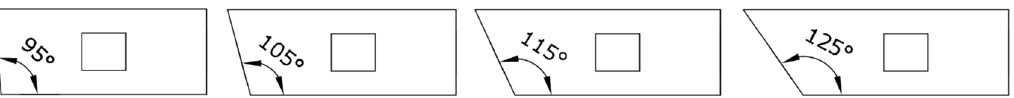
Figure 2. Pilot unit.